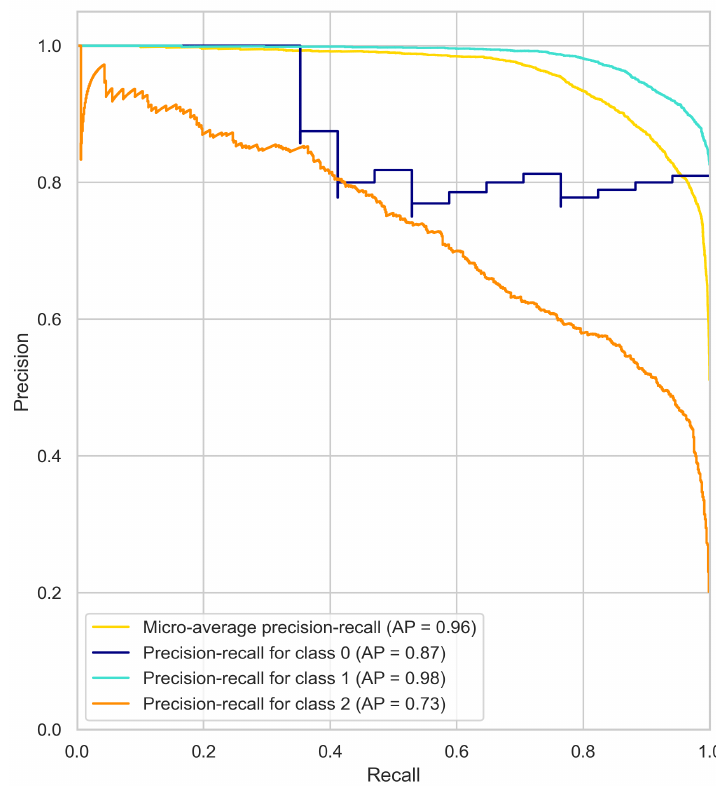
Figure 2. Precision–recall curve for SVM.